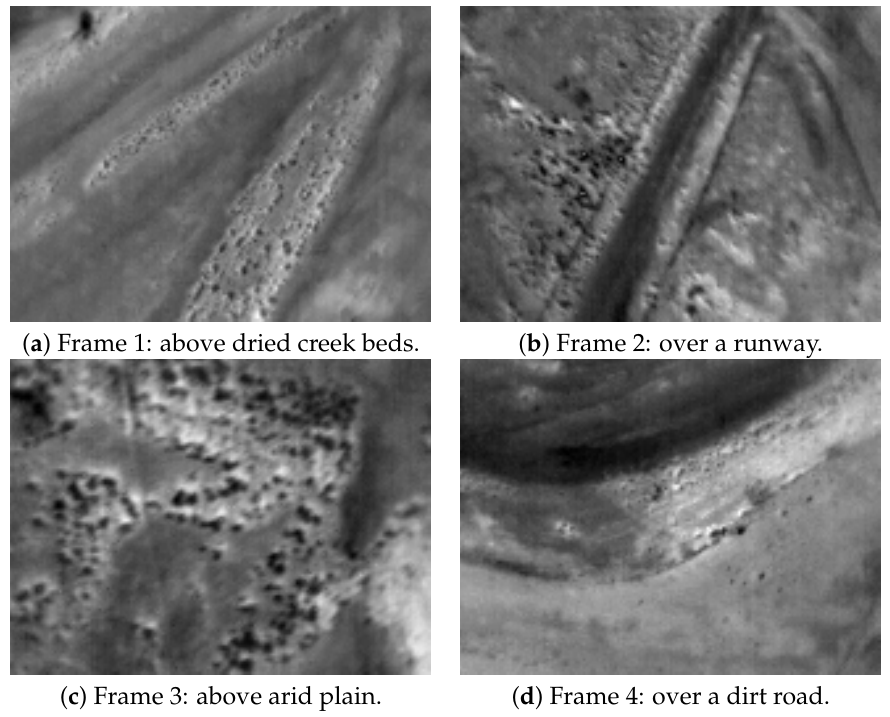
Figure 6. Some thermal frames of dataset 1, over some interesting features of the